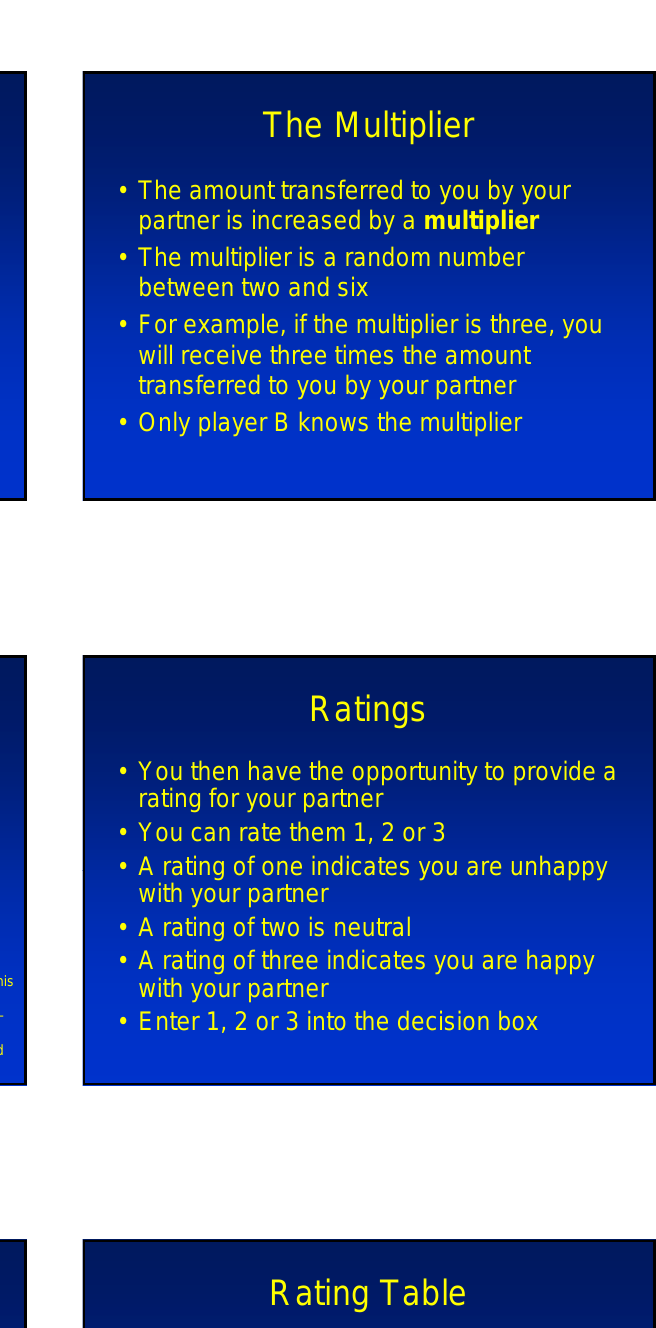
The rating table shows how each player was rated by their partner, and who that partner